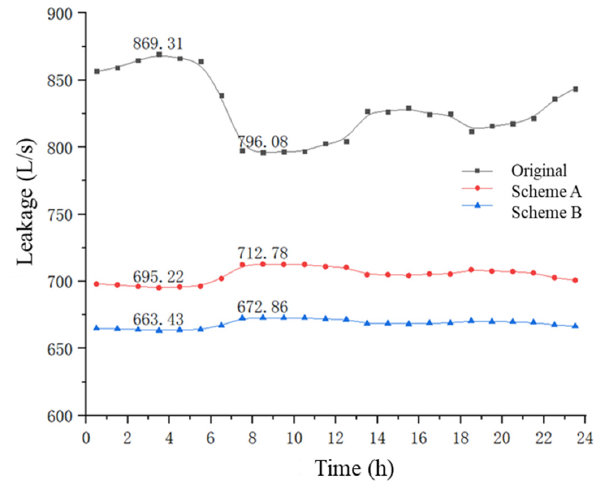
Figure 5. Statistics of leakage loss in three scenarios.